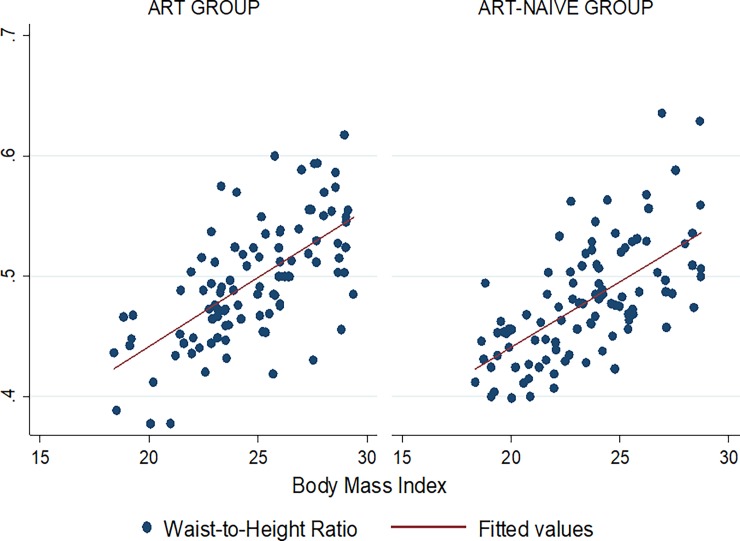
Linear regression model of the association between WHtR and BMI according to HAART status.